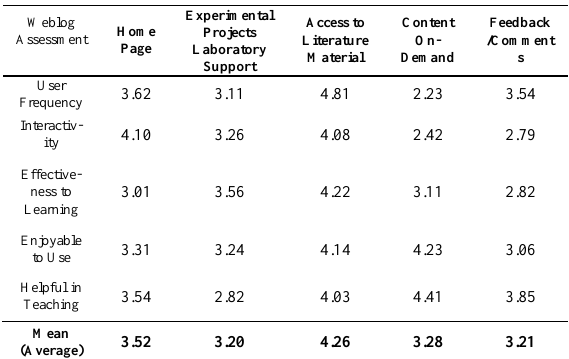
TABLE III. A CADEMIC P ROFESSORS FROM U NIVERSITY OF S ALFORD , P OLISH A CADEMY OF S CIENCES , W ARSAW , C OVENTRY U NIVERSITY AND BEING THE HIGHEST AND 1 THE LOWEST